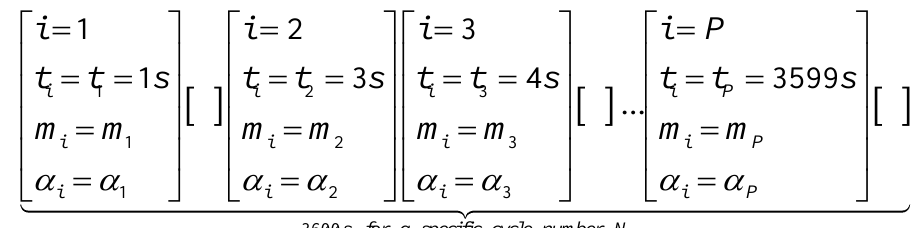
Figure 3. The schematic diagram of the stochastic process. 3600 s for a specific cycle number N